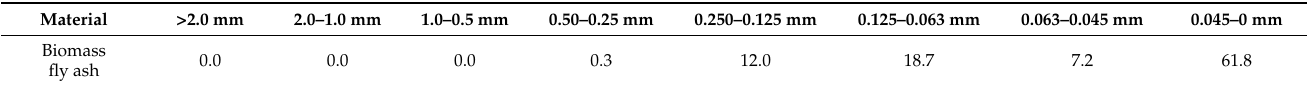
Table 3. Grain size distribution of biomass fly ash used in the study before